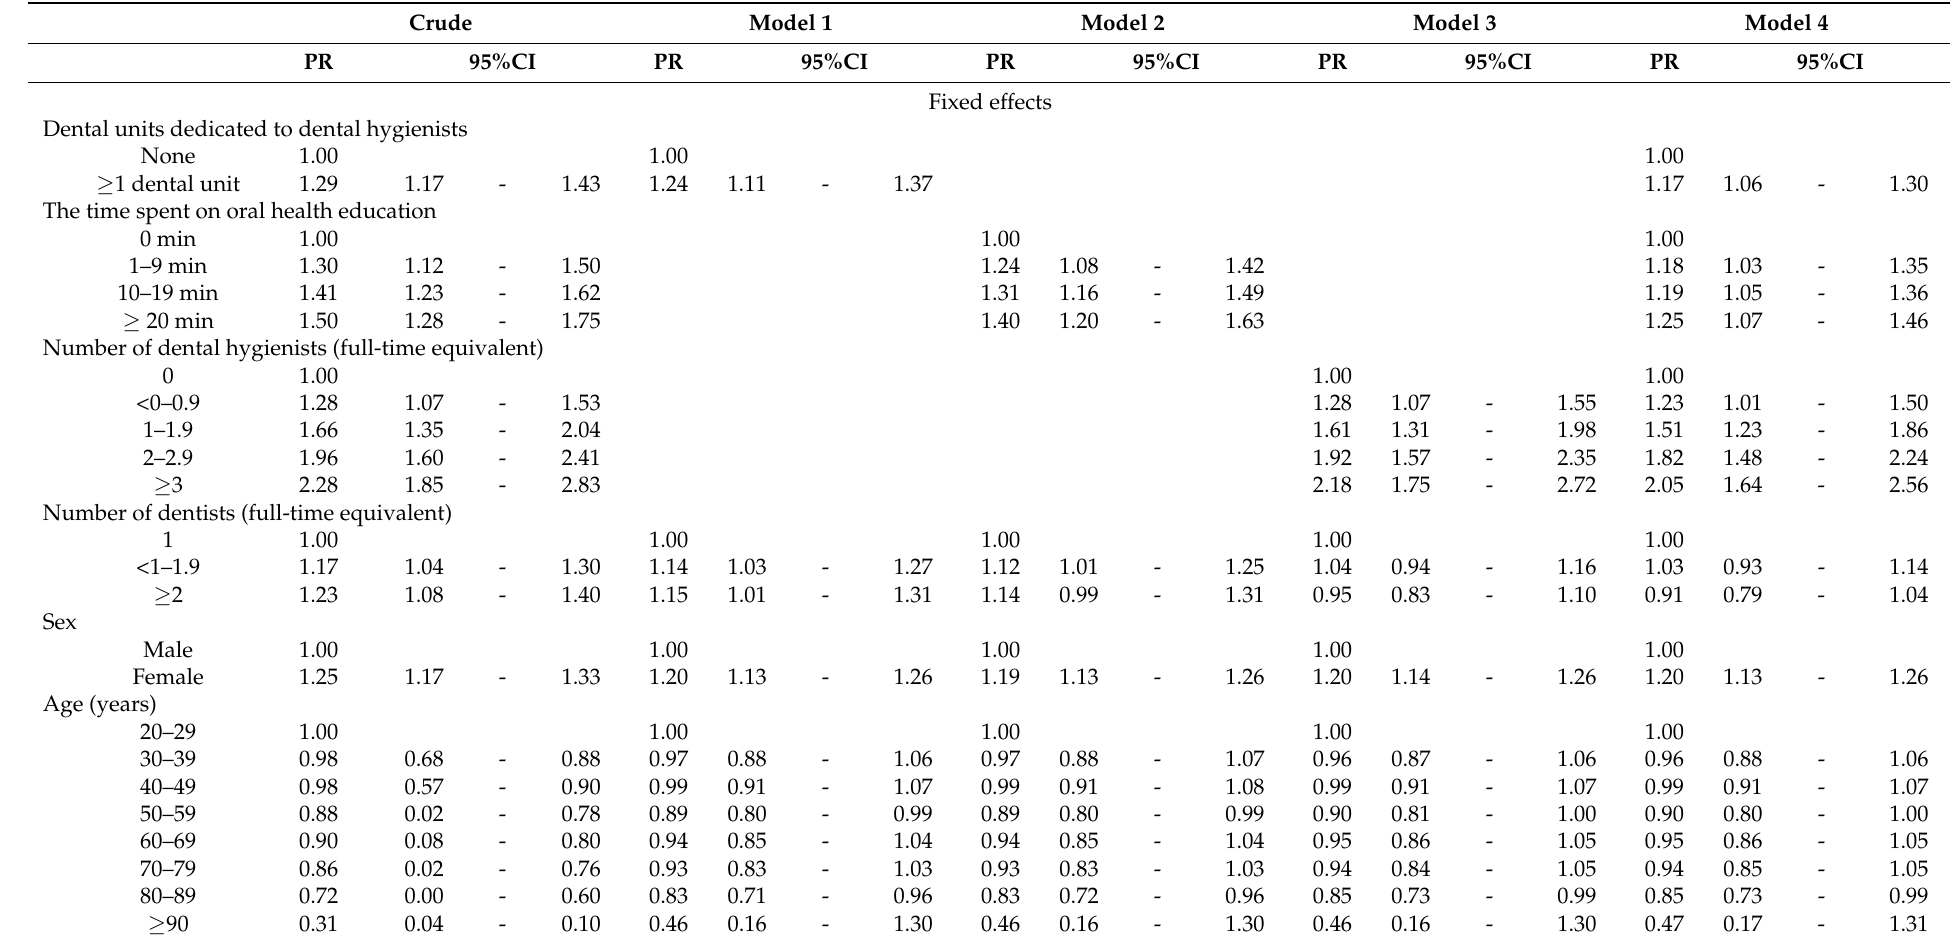
Table 2. Prevalence ratio (PR), median prevalence ratio, and variance partition coefficient for regular dental